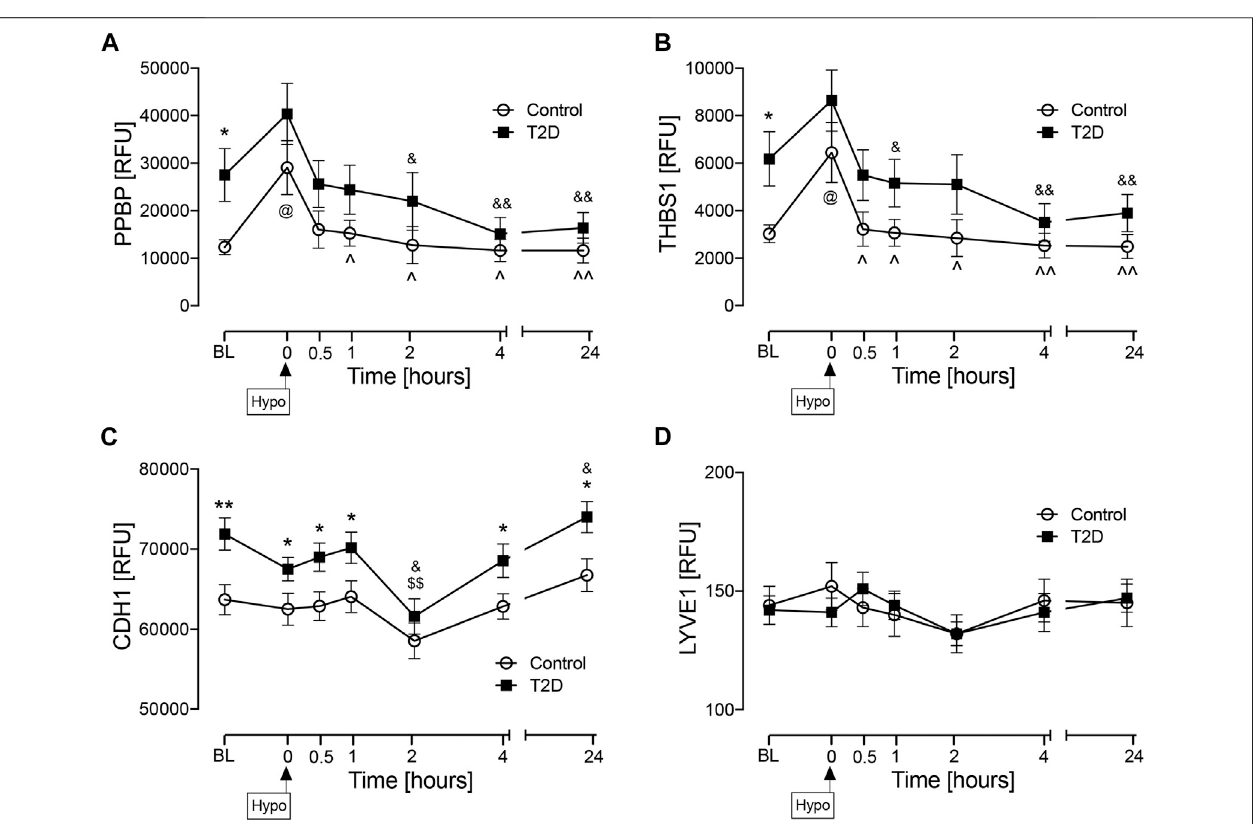
FIGURE2| Circulatorylevelsofendothelialcellmarkerproteinsatbaseline,athypoglycemiaandpost-hypoglycemiatimepointsinT2Dandcontrolsubjects.Blood samplingwasperformedatbaseline(BL),athypoglycemia(0 min)andpost-hypoglycemia(30 min,1-h,2-h,4-h,and24-h)forcontrols(whitecircles)andforT2D(black squares). At baseline (BL), blood sugar (BS) was 7.5 ± 0.4 mmol/L (for T2D) and 5.0 ± 0.1 mmol/L (for control, C). At the point of hypoglycemia, blood sugar (BS) was 2.0 ± 0.03 mmol/L (for T2D) and 1.8 ± 0.05 mmol/L (for control). Proteomic (Somalogic) analysis of proteins was undertaken for platelet basic protein (PPBP) (A) , thrombospondin-1 (THBS1) (B) , cadherin-1 (CDH1) (C) and lymphatic vessel endothelial hyaluronic acid receptor 1 (LYVE1) (D) . Statistics: T2D vs. control: * p < 0.05, ** p < 0.01; T2D BL vs. subsequent timepoints: $ p < 0.05, $$ p < 0.01; T2D hypoglycemia vs subsequent timepoints: & p < 0.05, && p < 0.01; Control BL vs. subsequent timepoints: @ p < 0.05; Control hypoglycemia vs. subsequent timepoints: ^ p < 0.05. ^^ p < 0.01. RFU, relative fl uorescent